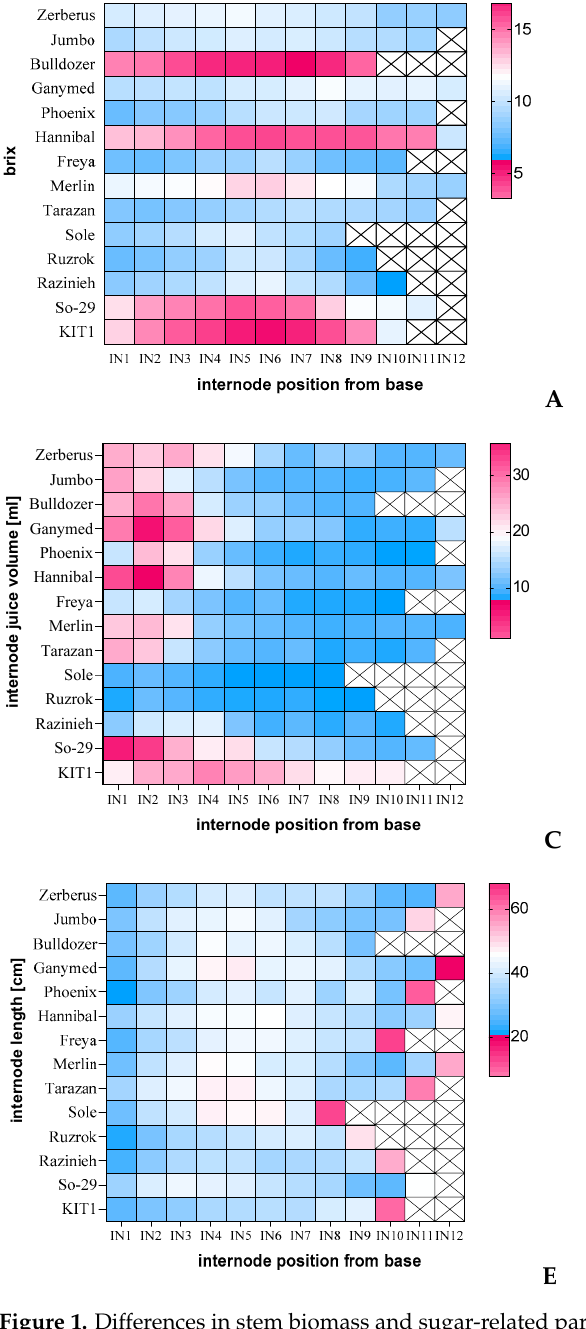
Figure 1. Differences in stem biomass and sugar-related parameters in the individual internodes of 14 sorghum genotypes grown in 2018 season in South-West Germany: ( A ) sugar concentration as ° Brix, ( B ) internode weight, ( C ) internode juice volume, ( D ) internode bagasse weight, and ( E ) internodes length. Values are means of three replicates (5 samples in each replicate). Boxes with x indicate the absence of the internode. The blue color represents the trend of decrease and the purple color represents a rising trend. Heat map was generated using GraphPad Prism 8.4.3 software.